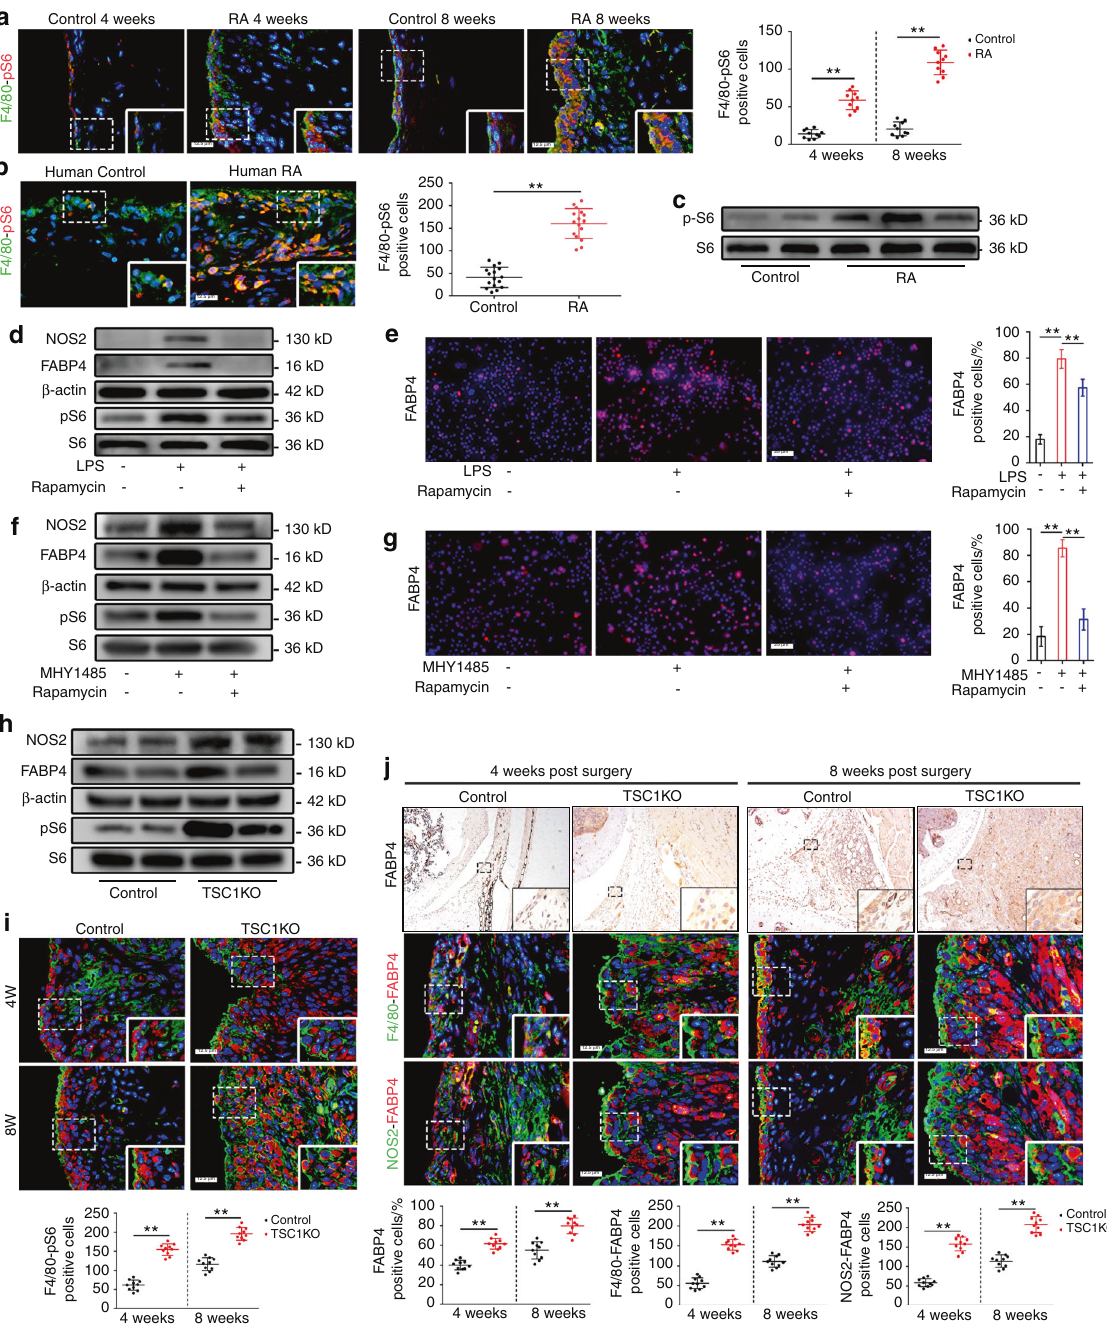
Fig. 4 Activation of the mTORC1 pathway enhances the secretion of FABP4 by M1-polarized macrophages to exacerbate RA progression. a , b Representative images and quanti fi cation of F4/80 and pS6 coimmunostaining in the mouse ( n = 10 per group) ( a ) and human synovium ( n = 16 per group) ( b ) of the control and RA groups. Scale bar: 12.5 µm. c Western blot showing S6 and pS6 in human synovial tissue. d Western blot showing FABP4, NOS2, S6 and pS6 in BMDMs treated with LPS or rapamycin. e Representative immuno fl uorescence staining images and quantitative analysis of FABP4 in BMDMs stimulated with LPS or rapamycin ( n = 3 per group). Scale bar: 100 µm. f Western blot showing FABP4, NOS2, S6 and pS6 in BMDMs treated with MHY1485 or rapamycin. g Representative immuno fl uorescence staining images and quantitative analysis of FABP4 in BMDMs treated with MHY1485 or rapamycin ( n = 3 per group). Scale bar: 100 µm. h Western blot showing FABP4, NOS2, S6 and pS6 in BMDMs from control and TSC1KO mice. i Representative images and quanti fi cation of F4/80 and pS6 coimmunostaining in the synovium of wild-type and TSC1KO mice at 4 and 8 weeks after AIA modeling ( n = 10 per group). Scale bar: 12.5 µm. j Representative images and quanti fi cation of FABP4 immunohistochemical staining and coimmunostaining of FABP4 with F4/80 or NOS2 in the synovium of control and TSC1KO mice at 4 and 8 weeks after AIA modeling ( n = 10 per group). Scale bars: 12.5 µm and 100 µm. f – j Representative images ( f ) and quanti fi cation of Vimentin and MMP3 coimmunostaining ( g ), CD31 and EMCN coimmunostaining ( h ), Col2a1 immuno fl uorescence staining ( i ), and MMP13 immunohistochemical staining ( j ) in the knee joints of controls and TSC1KO mice at 4 and 8 weeks after AIA modeling ( n = 10 per group). Scale bar: 12.5 µm, 25 µm, and 100 µm. Student ’ s t -test or one-way ANOVA and Tukey ’ s multiple comparison test. ** P < 0.01. The data are shown as the mean ±